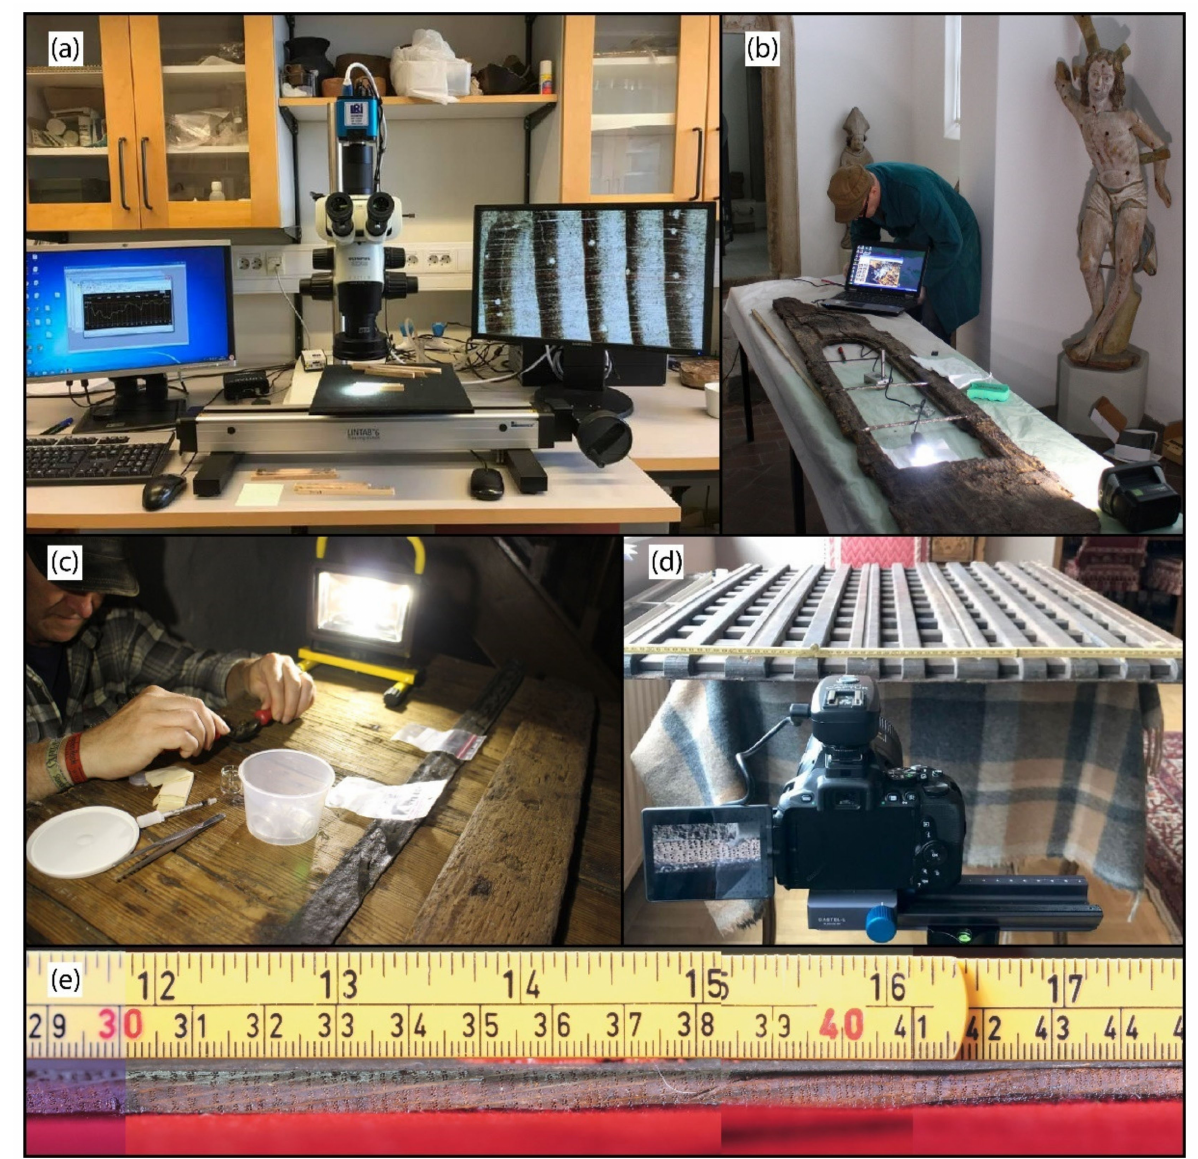
Figure 1. ( a ) Tree-ring measurements directly on a core from a pine tree. ( b ) Micro-invasive image analysis on a window frame from Ignaberga church based on high resolution images taken with USB-microscope. ( c ) Measurement on a horizontal door leaf. In parallel with the measurements small wood samples were taken to allow for radiocarbon dating if the dendrochronological analysis would not yield a reliable result. ( d ) Micro-invasive image analysis on an oak panel based on high resolution macro photos. Note the magnified annual rings on the camera screen. ( e ) Composite pictures of an oak plank from macro photos. The scale is helpful when the images are to be linked together and to calibrate the image before the annual rings are to be